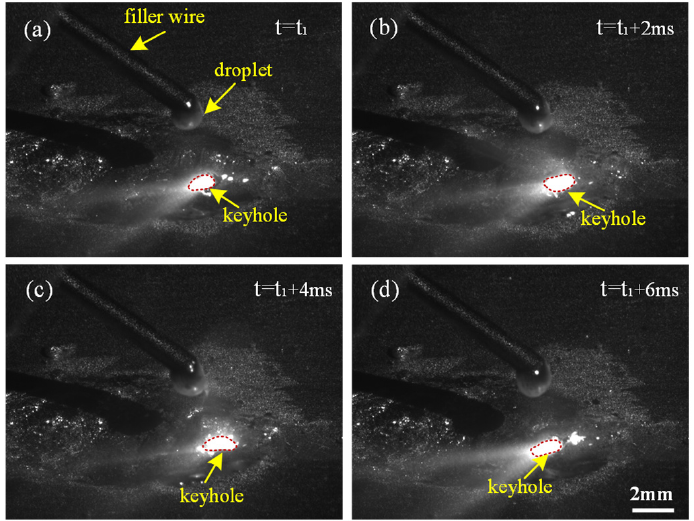
Figure 3. Experimentally observed keyhole fluctuation during the droplet growth stage. ( a ) t = t 1 ; ( b ) t = t 1 + 2 ms; ( c ) t = t 1 + 4 ms; ( d ) t = t 1 + 6 ms.